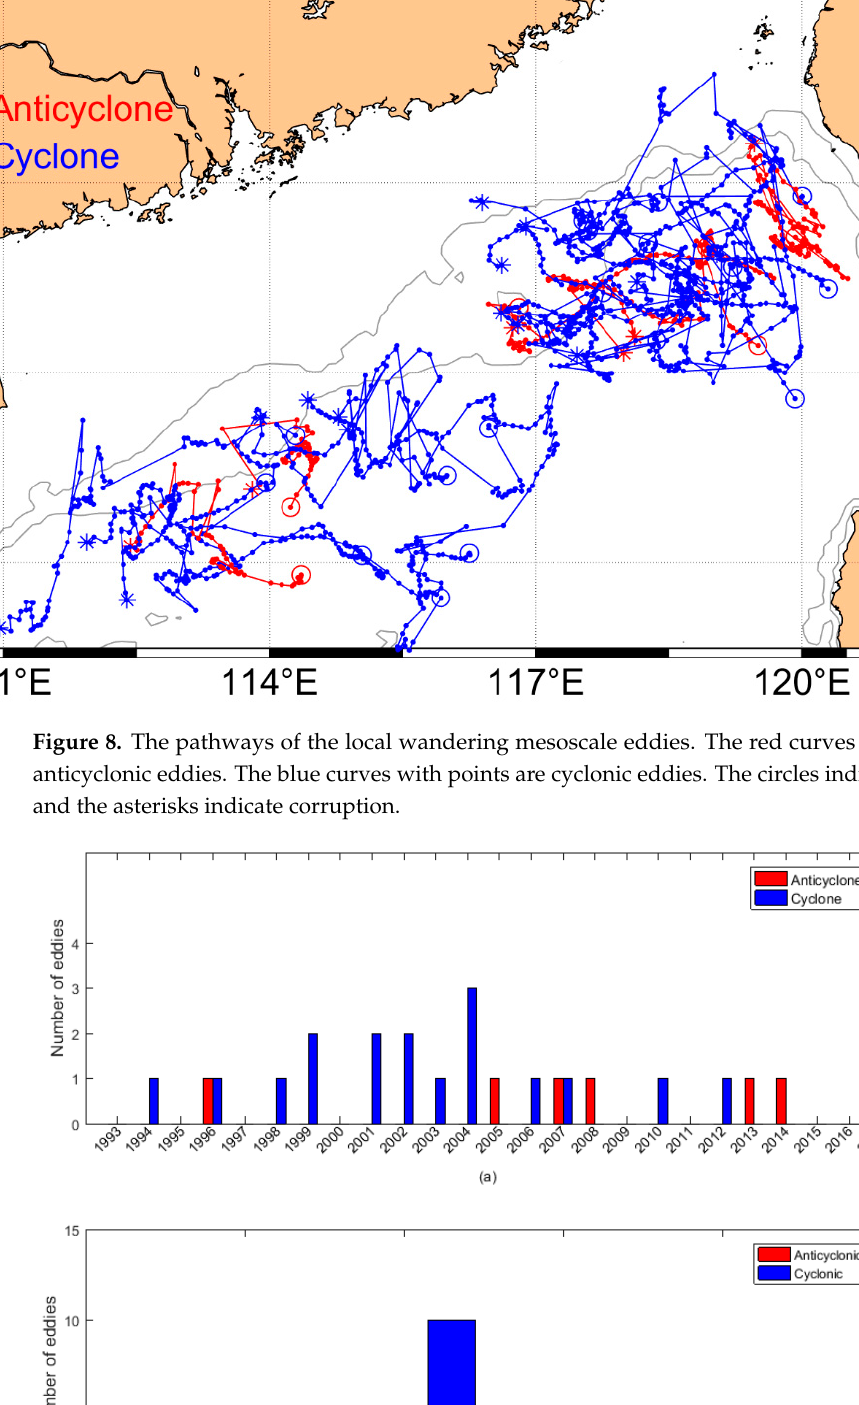
Figure 9. ( a ) Interannual and ( b ) seasonal statistics of the local wandering type. The red columns indicate the anticyclonic eddies. The blue columns indicate the cyclonic eddies.